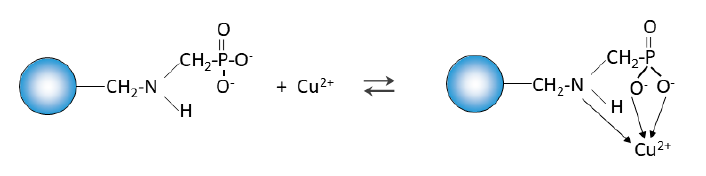
Figure 16. Proposed sorption mechanism.